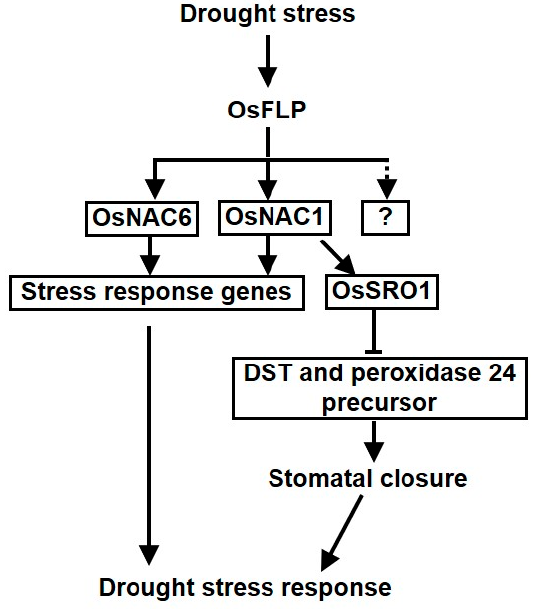
Figure 7. Proposed working model of OsFLP mediated drought stress response in rice. Under drought stress conditions, OsFLP expression levels are highly induced. Then, OsFLP specifically binds to the promoter region of OsNAC1 and OsNAC6 to increase the transcriptional expression of these genes. On the one hand, OsNAC1 and OsNAC6 can exclusively induce stress response genes; and on the other hand, OsNAC1 enhanced the stomatal closure by inhibiting the DST and peroxidase 24 precursor . Ultimately, rice plants confer drought tolerance.